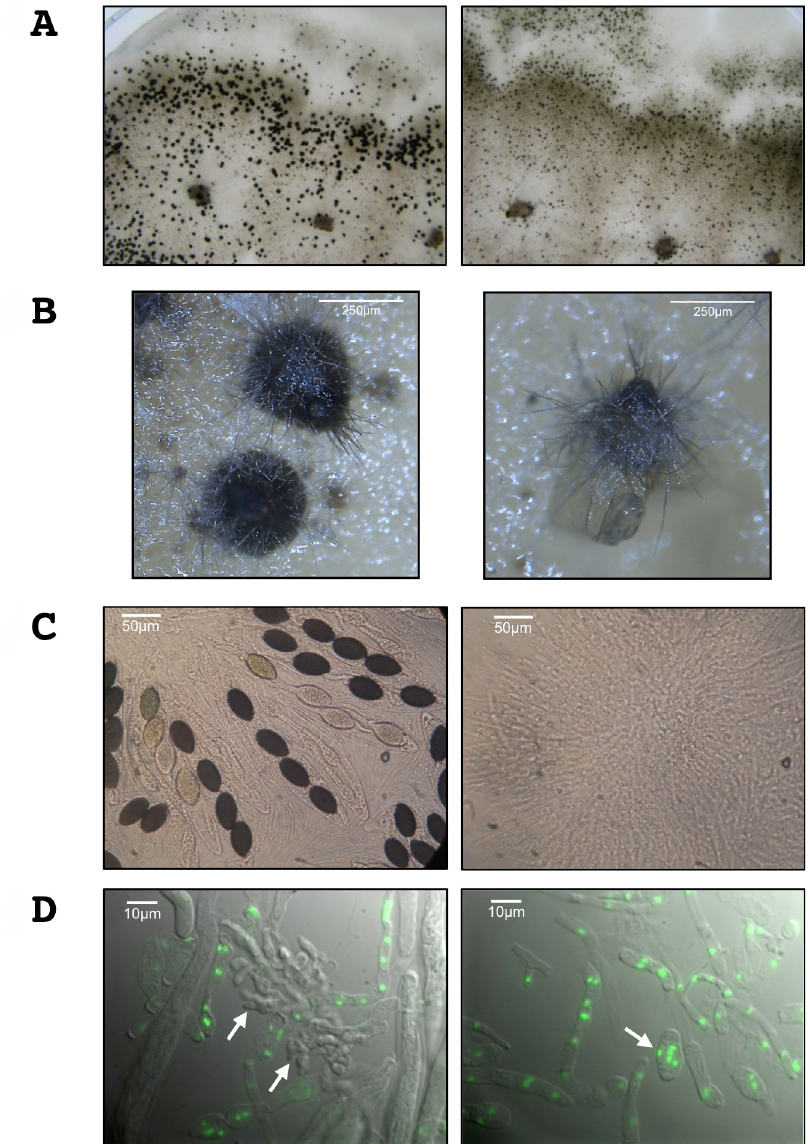
Fig 4. PaRid is essential to complete fruiting body development and to produce ascospores. ( A ) Homozygous crosses of wild type S strains (left panel) and of Δ PaRid strains (right panel) on M2 medium after 5 days at 27˚C. Each dark dot is one fruiting body resulting from one event of fertilization. The homozygous Δ PaRid cross forms reduced- size fruiting bodies only (right panel). ( B ) Close up of fruiting bodies (perithecia) originating from either a wild-type genetic background (left panel) or a Δ PaRid genetic background (right panel). Scale bar: 250 μ m. ( C ) After 4 days of growth at 27˚C, the wild type fruiting bodies start to produce ascospores (left panel) while the mutant micro-perithecia are barren (right panel). Scale bar: 50 μ m. ( D ) Fluorescence microscopy pictures of 48h-old fruiting body content from homozygous crosses of wild type S strains (left panel) and of Δ PaRid strains (right panel), performed on M2 medium at 27˚C. The nuclei are visualized thanks to histone H1-GFP fusion protein. Croziers are readily formed inside the wild type perithecia (left panel, white arrows) while no crozier but large plurinucleate ascogonial cells only are seen inside the Δ PaRid perithecia (right panel, white arrow). Scale bar: 10 μ